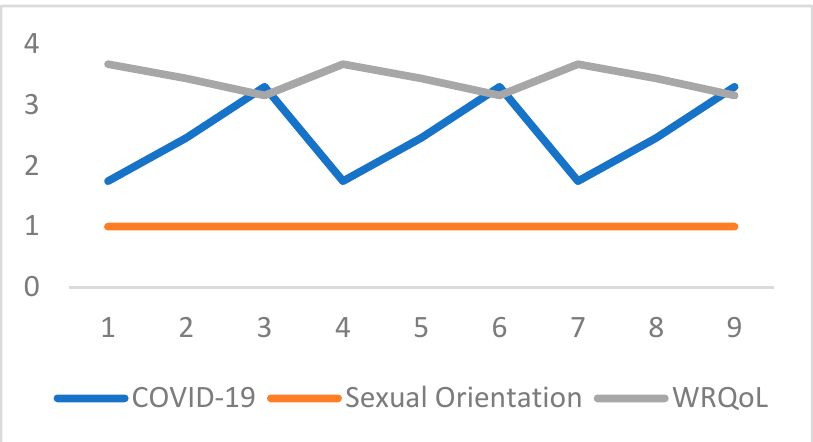
Figure 1. Simple slopes mapping the fear of and negative impact of COVID-19 predicting WRQoL as moderated by sexual orientation. ( p < 0.001).